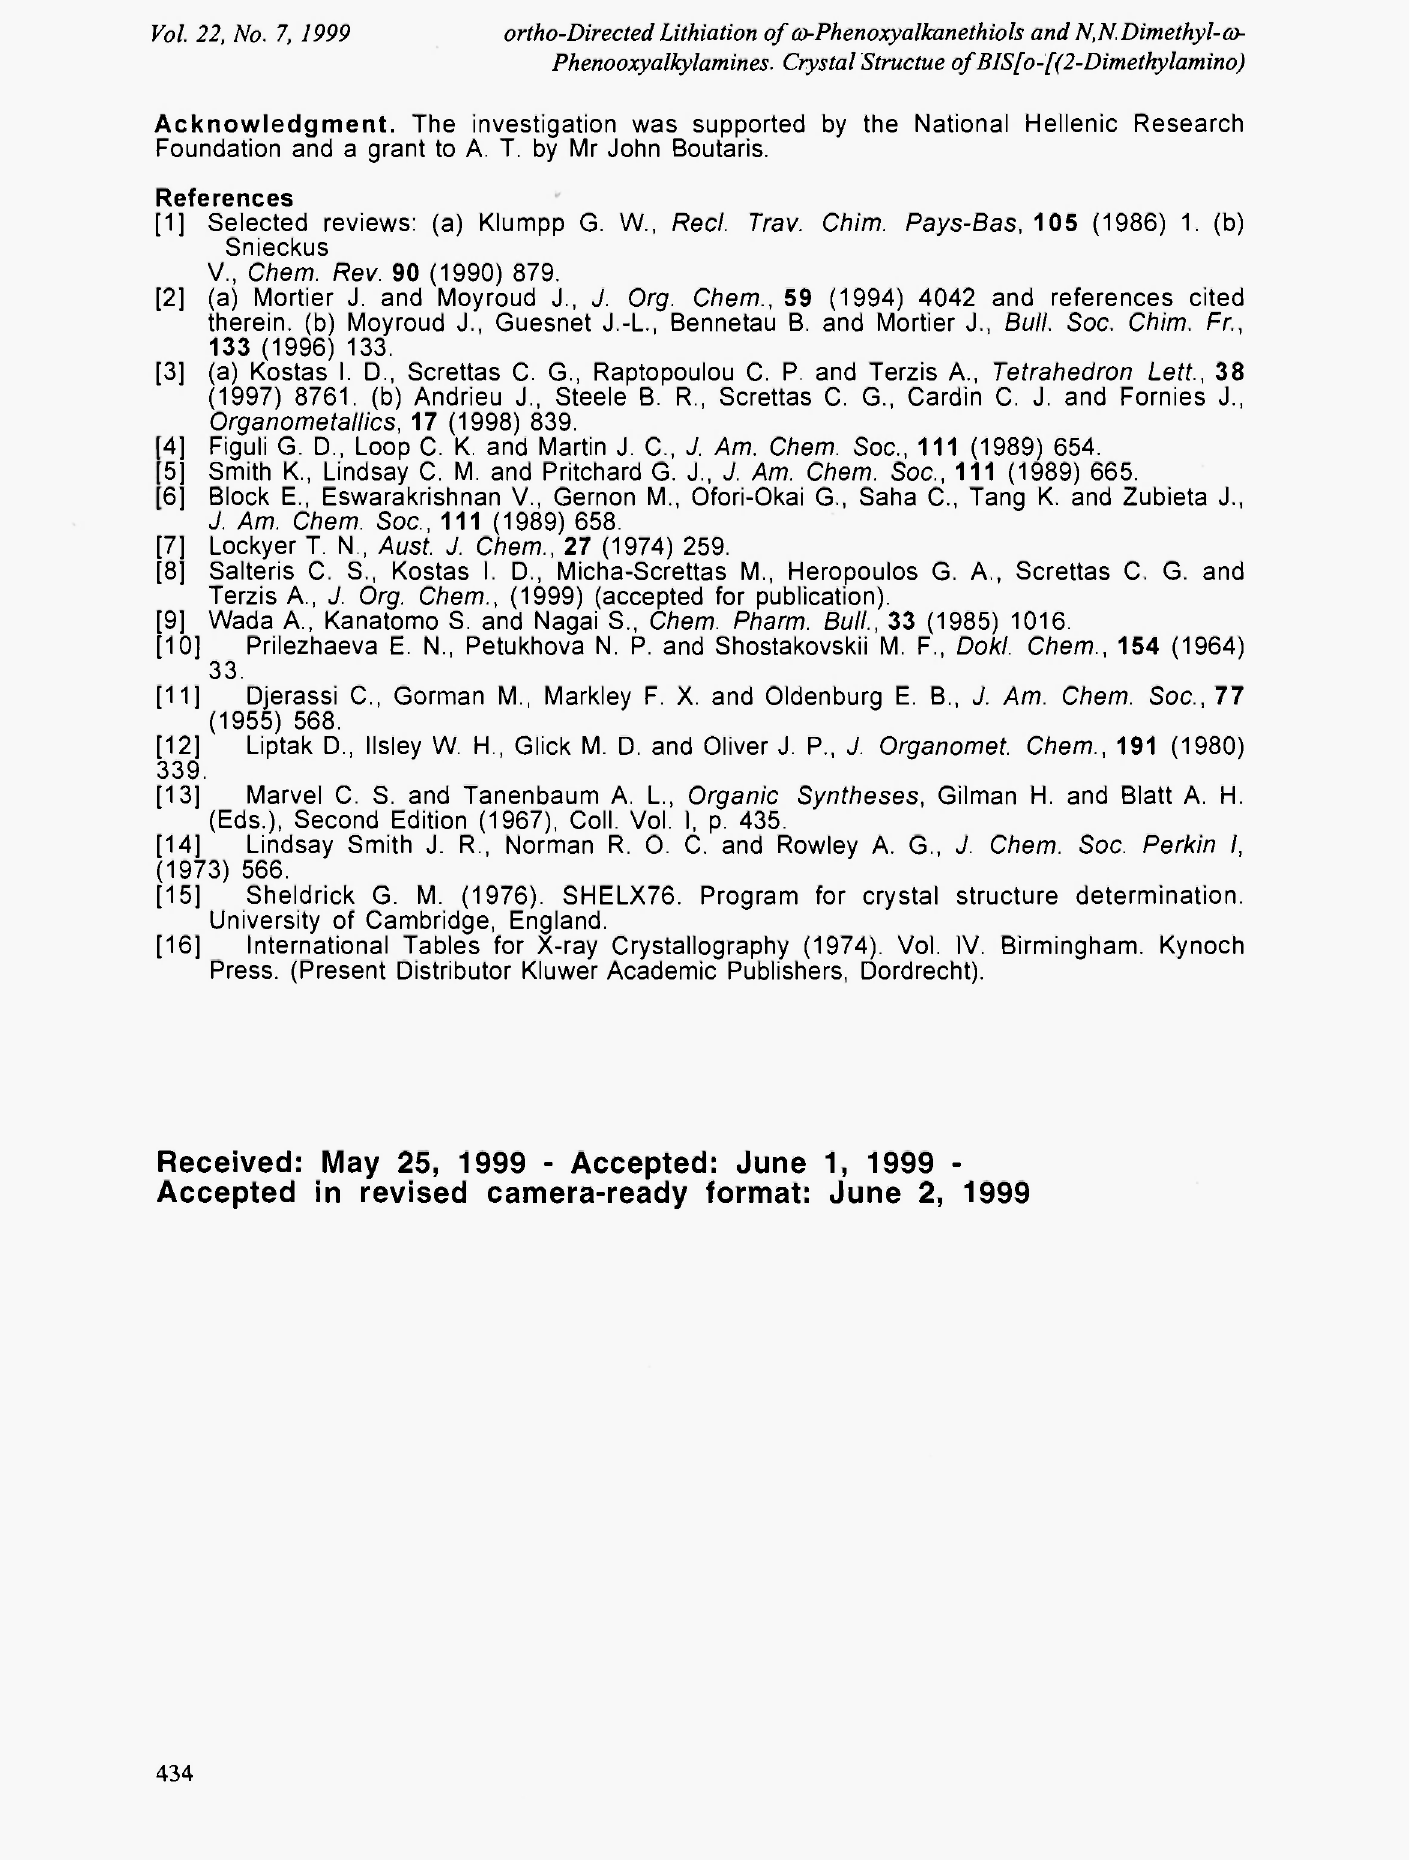
Figuli G. D., Loop C. K. and Martin J. C., J. Am. Chem. Soc., 111 (1989)